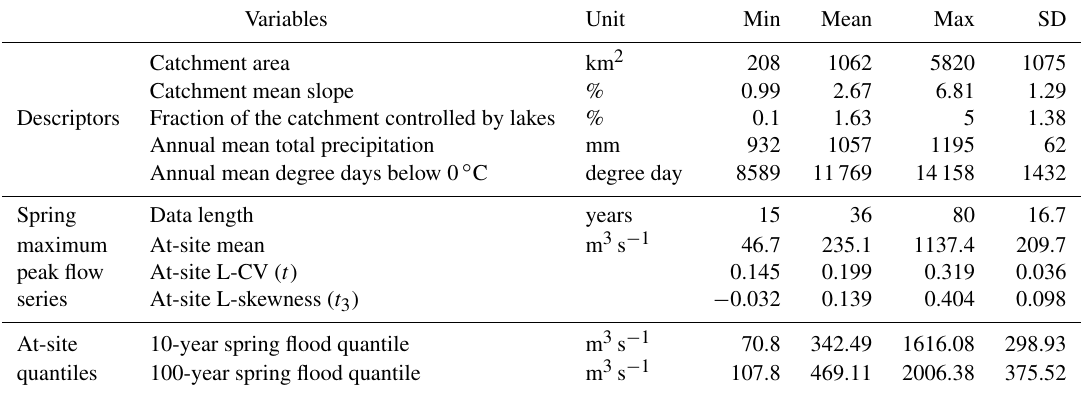
Table 3. Summary of the statistics of descriptors, spring maximum peak flow series, and available at-site quantiles for the 44 sites considered in the illustrative application.